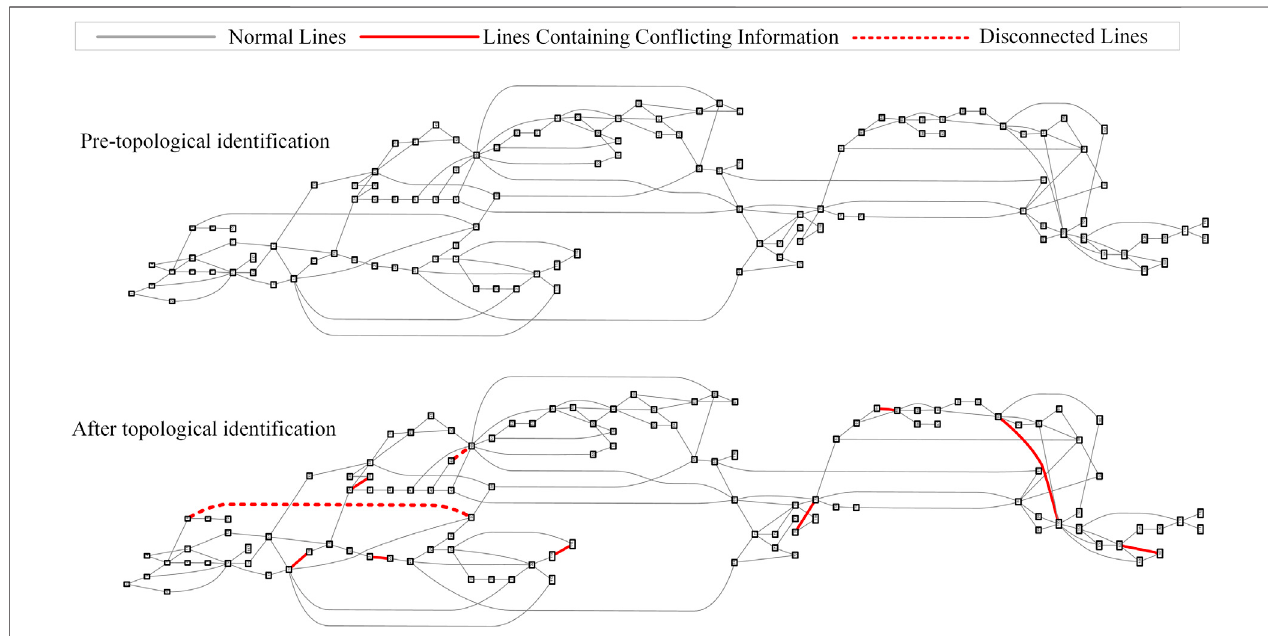
FIGURE 7 | Comparison of results of topological identi fi